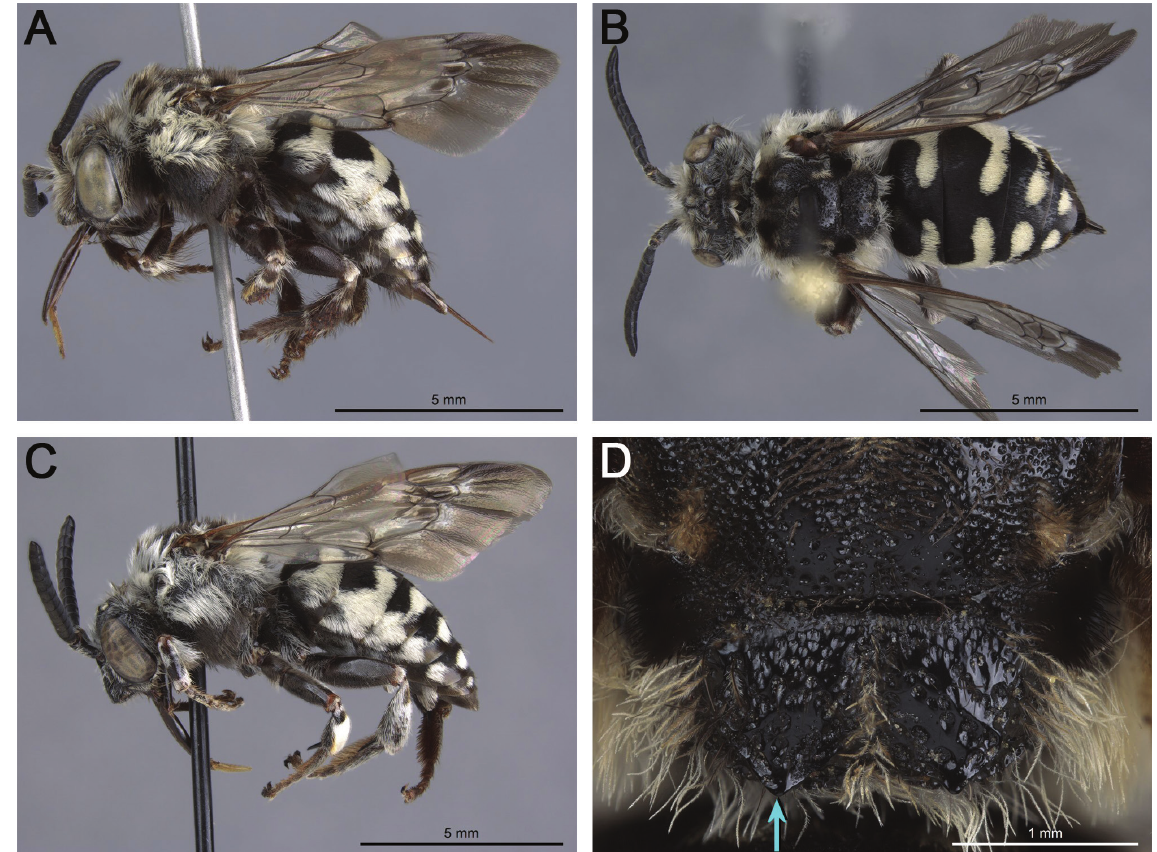
Fig. 5. Brachymelecta californica (Cresson, 1878). A . Female (PCYU PYU-2276), habitus, lateral view. B . Female (BOLD sample ID: CCDB-34570 A07; PCYU), habitus, dorsal view. C . Male (BOLD sample ID: CCDB-34570 A11; PCYU), habitus, lateral view. D . Female (PCYU PYU-2391), axillae and mesoscutellum, dorsal view (blue arrow indicates one of two short, mammiform tubercles of